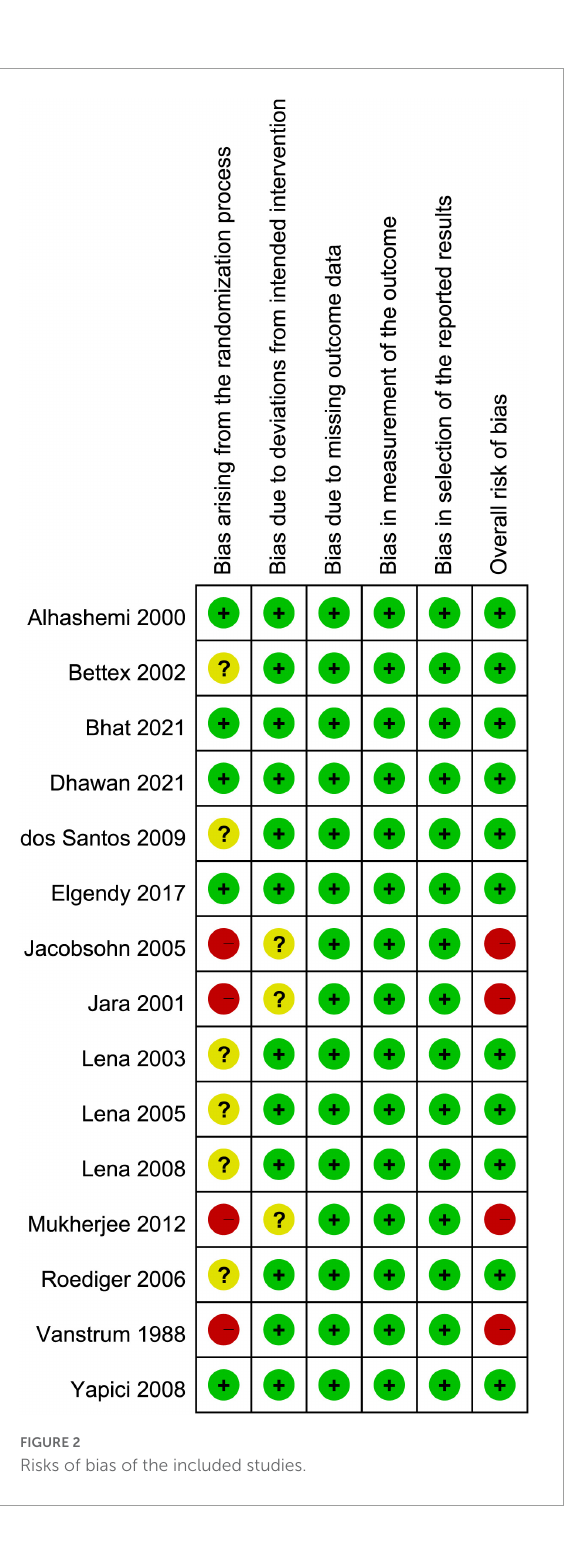
information size on TSA suggested inadequate evidence for this outcome ( Supplementary Figure 14 ). Similarly, the cumulative Z -curve did not cross the futility boundary for hospital/ICU LOS and risk of nausea/vomiting, implicating inconclusive evidence for these outcomes ( Supplementary Figures 16–18